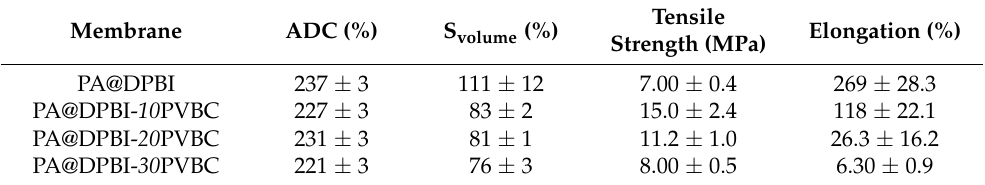
Table 2. PA uptake, and mechanical properties of PA doped DPBI- x PVBC membranes. Membrane